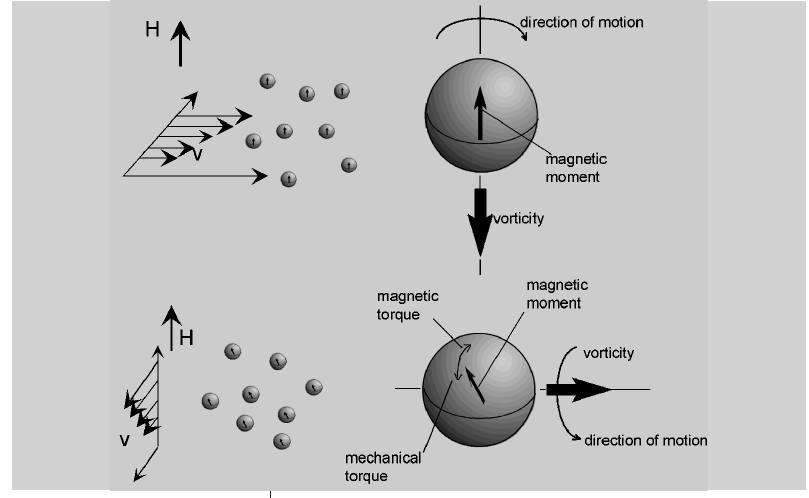
Figure 1 (left): The origin of rotational viscosity. Explanations are given in the text. Figure 2: Comparison of the experi- mental data from [9] with the theoretical approach in Eq. 1 [10] (Full circles: field perpendicular to the flow; Open circles: field parallel to the